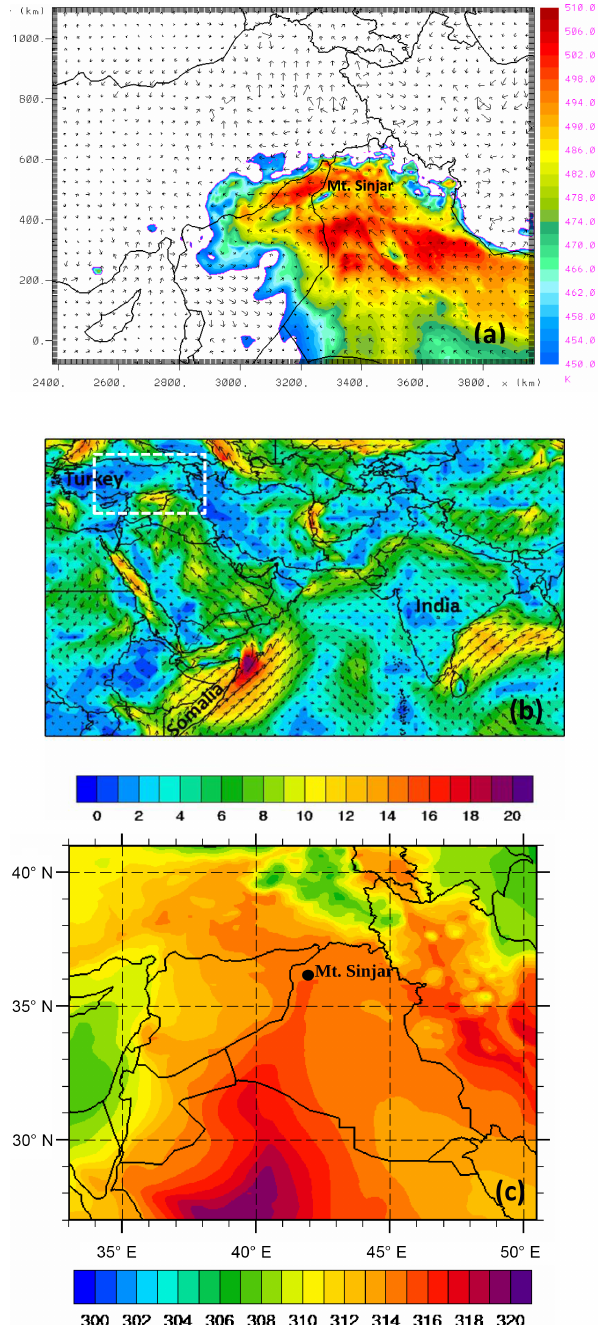
Figure 6. (a) Model equivalent potential temperature (K) and wind vectors at 50m above ground on 6 September 2015, 13:00UTC. (b) Wind speed at 975mbar from the NCEP final analysis (FNL) dataset on 6 September 2015, 06:00UTC. The white rectangle in- dicates the location of the model domain shown in (a) . (c) Model 1000–700mbar thickness (dam) on 6 September 2015,